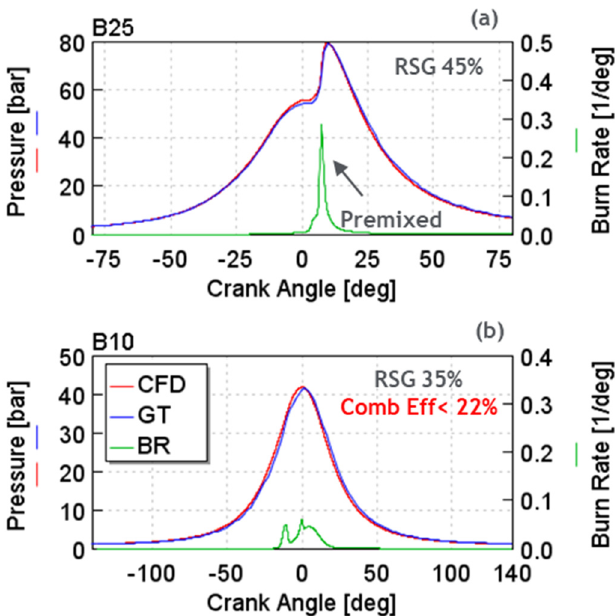
Figure 6. Comparison of in-cylinder pressure between the 1-D and the 3-D models at ( a ) B25 and ( b ) B10 for RON93 gasoline at CR 15.7.